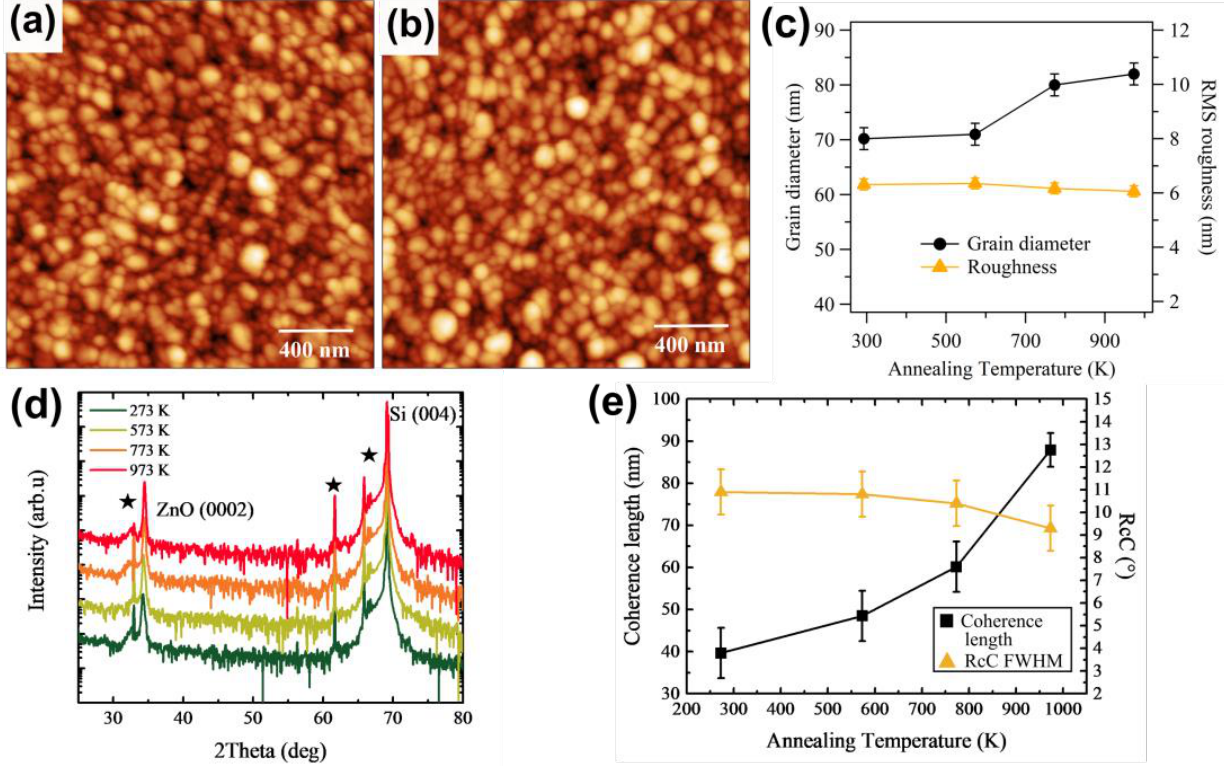
Figure 1. AFM images of size 2 × 2 µm 2 (tapping mode) of ( a ) RT-grown ZnO film and ( b ) after post-growth annealing in 50% O 2 and 50% N 2 at 773 K. ( c ) Average grain diameter (black dot) and RMS roughness (orange triangle) as obtained by grain analysis of AFM images of surface shown in ( a ) as a function of annealing temperature. ( d ) XRD plots, ( e ) coherence length (black squares) and rocking curve FWHM (orange triangle) for increasing annealing temperature. The XRD signals are vertically shifted by a constant to better observe the differences. Stars in ( d ) indicate the replica peaks due to the non-monochromatized X-ray source.